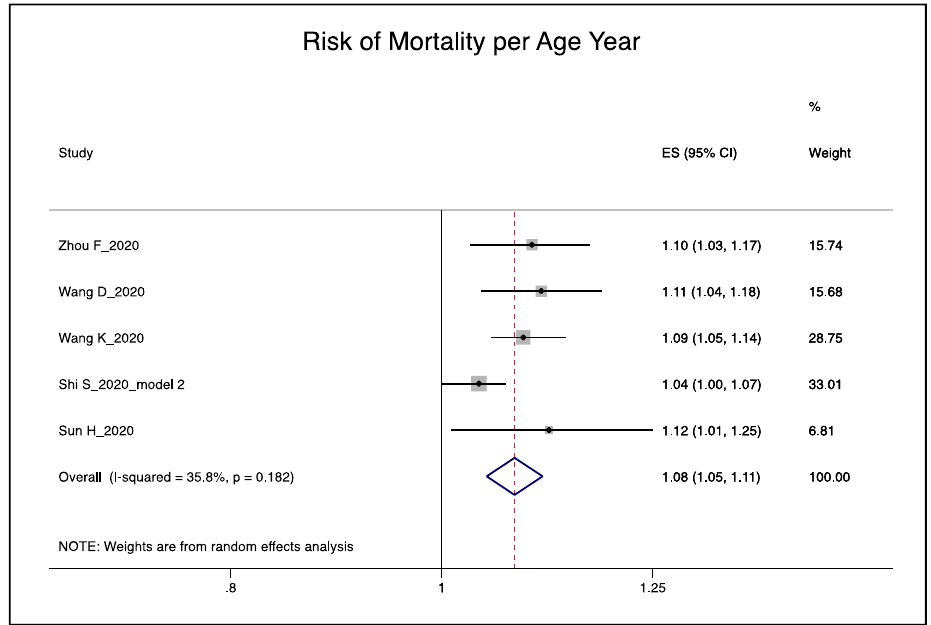
Figure 4. Pooled effect of the risk of age on mortality, random-effects meta-analysis.